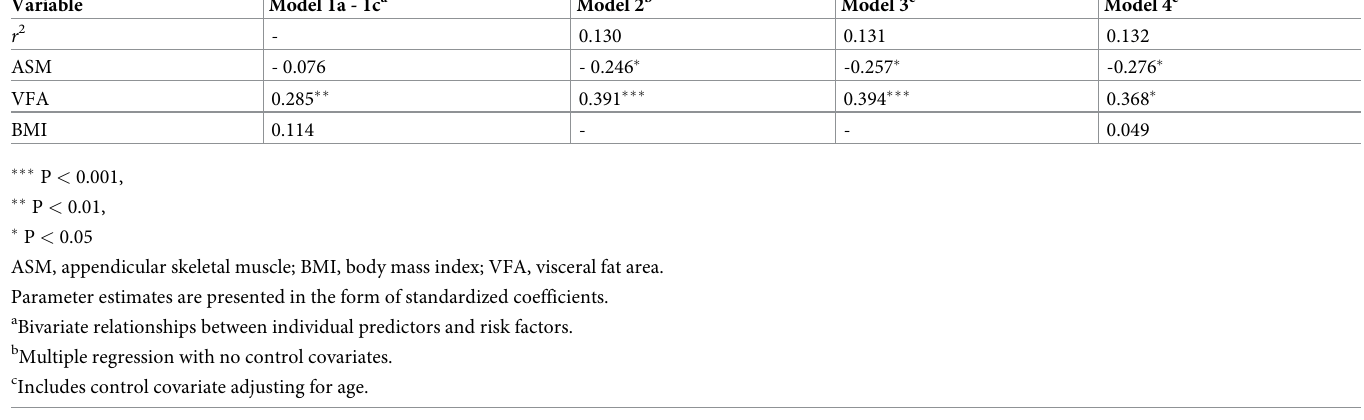
Table 2. Multiple regression analysis of the number of metabolic cardiovascular risk factors.